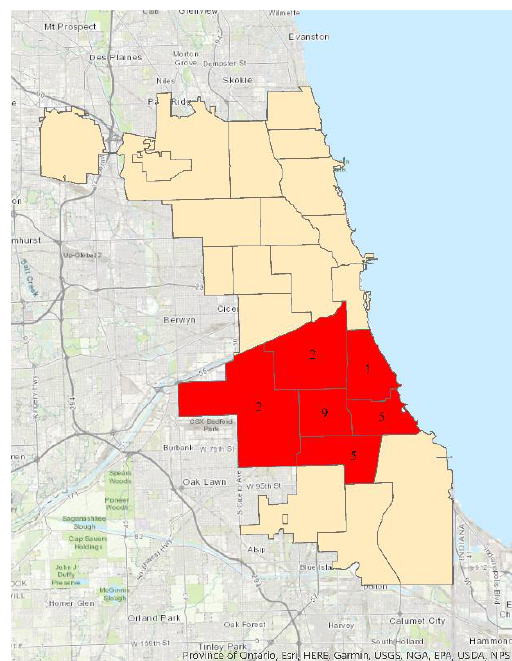
Figure 6. High value clusters by month at police district level (number in the polygon represents the frequency of clusters)